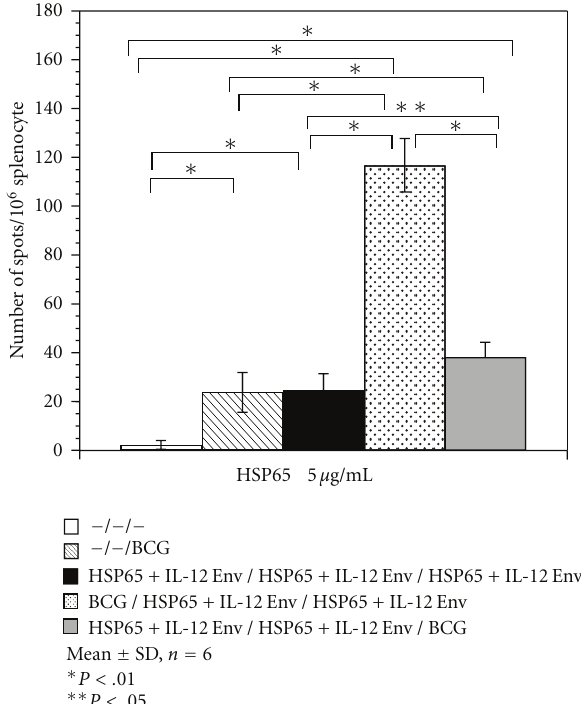
Figure 8: ELISPOT assay for IFN- γ antigen-specific responses in the spleens of vaccinated mice following stimulation with rHSP65 protein. Spleen cell cultures were stimulated with rHSP65 protein for 20h. The numbers of IFN- γ -secreting cells specific for rHSP65 protein per million cells were determined individually by ELISPOT assay. Results are expressed as the mean ± S.D. of 6 wells of 3 mice per group. The statistical significance of di ff erences between individual groups in the number of IFN- γ -secreting cells was determined by Dunnett test. The statistical significance of di ff erences ( P < . 01) of the G1 (naive) group compared to the G2 (BCG alone group), G3 (DNA/DNA/DNA), G4 (BCG/DNA/DNA), or G5 (DNA/DNA/BCG). The statistical significance of the G2 group di ff erence ( P < . 01) compared to the G4 or the G5. The statistical significance of the G3 group di ff erences ( P < . 01) compared to the G4. P < . 01; the G4 group compared to the G5. The statistical significance of the G3 group di ff erences ( P < . 05) compared to the